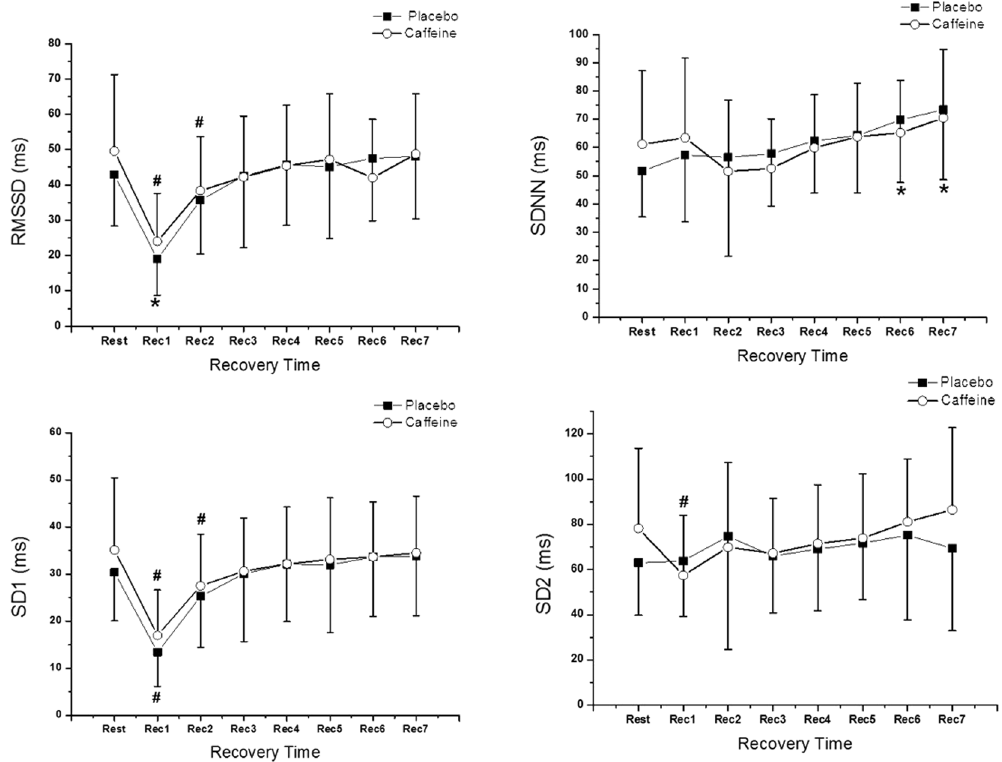
Figure 3. Mean values and their respective standard deviations of indices in the time domain during rest and recovery (Rec), obtained from the placebo and caffeine protocols. * Values with significant differences in relation to rest (Friedman test followed by the Dunn test; p < 0.05); # Values with significant differences in relation to rest (ANOVA for repeated measures followed by the Bonferroni test, p <